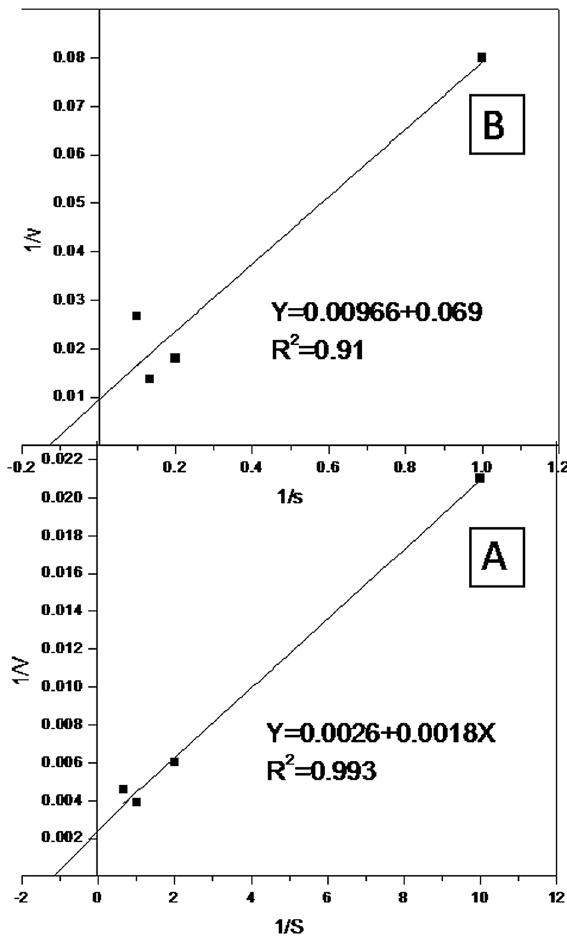
Figure 7. Lineweaver–Burk plot of the partially purified enzyme. ( A ) Protease using casein as the substrate and ( B ) keratinase using keratin-azure as the